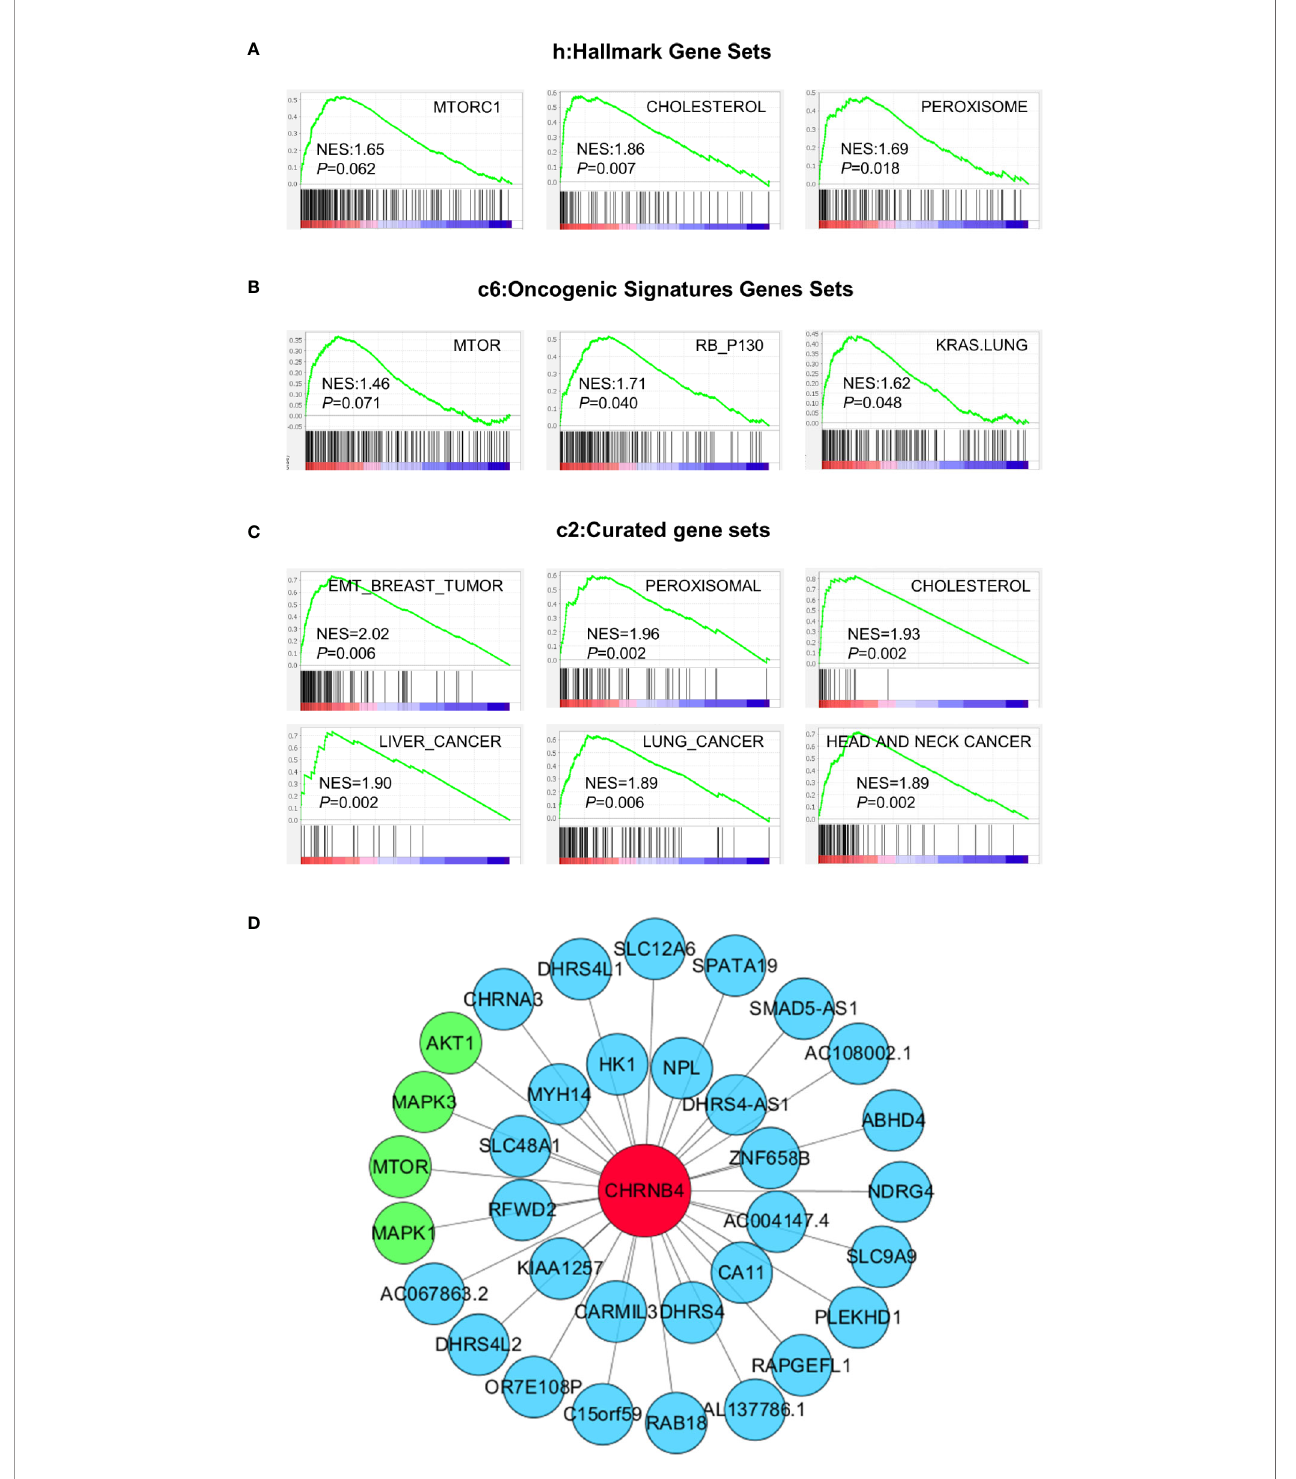
FIGURE 4 | GSEA results based on the expression of CHRNB4 in TCGA and Co-expression pictures of CHRNB4. (A – C) Signi fi cantly enriched gene sets were obtained according to hallmark gene sets (h), oncogenic signatures gene sets (c6), and curated gene sets (c2). The gene sets highly correlated with tumor were presented. (D) The pictures were shown that the relativity between the gene CHRNB4 and the relevant genes. The red nodes are CHRNB4. The green nodes are the genes of the mTOR signaling pathways and blue nodes are many other less well-known